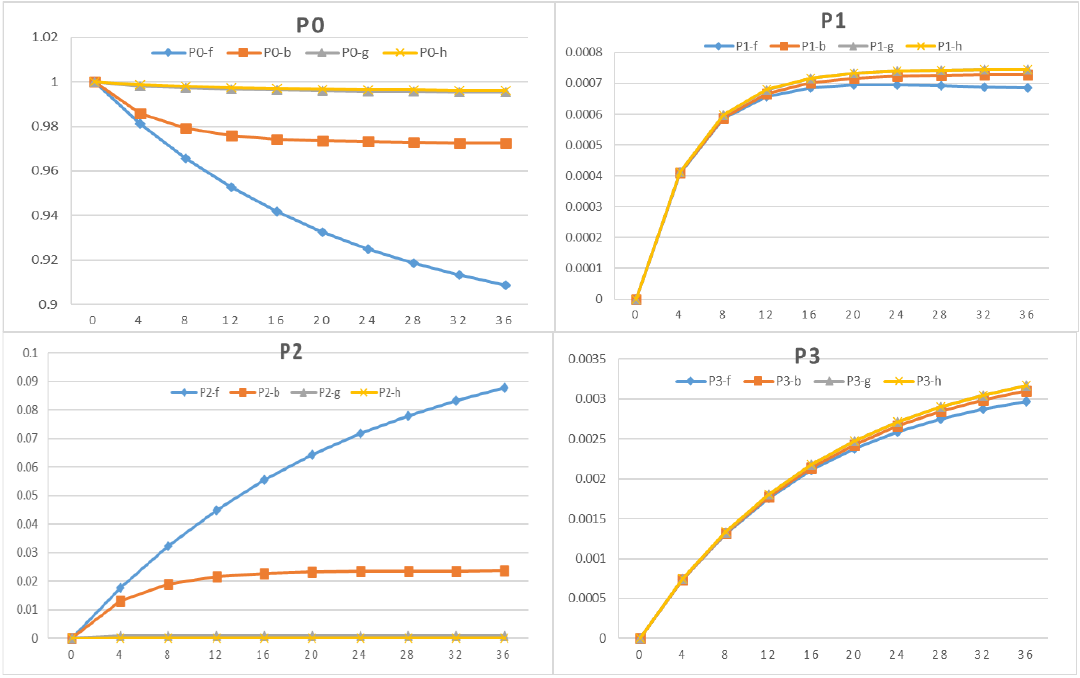
Figure 7. Probabilities of each disk state for different recovery rates r vg ( x -axis: mission